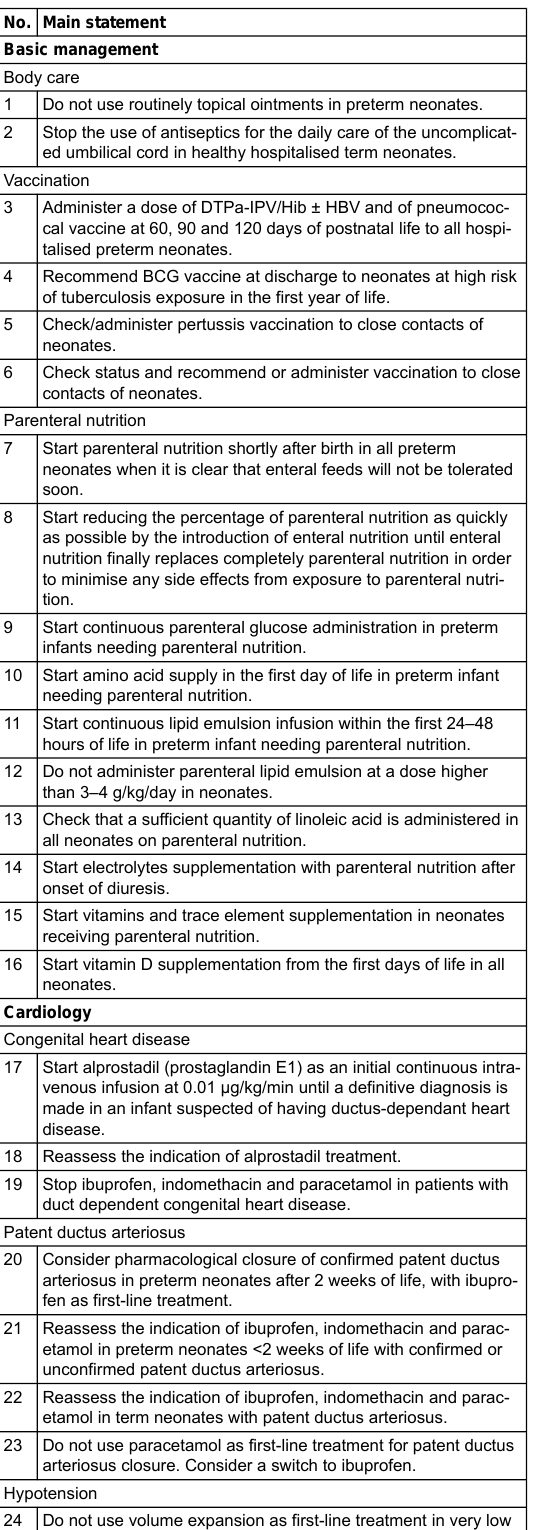
Table 5: The NeoCheck validated